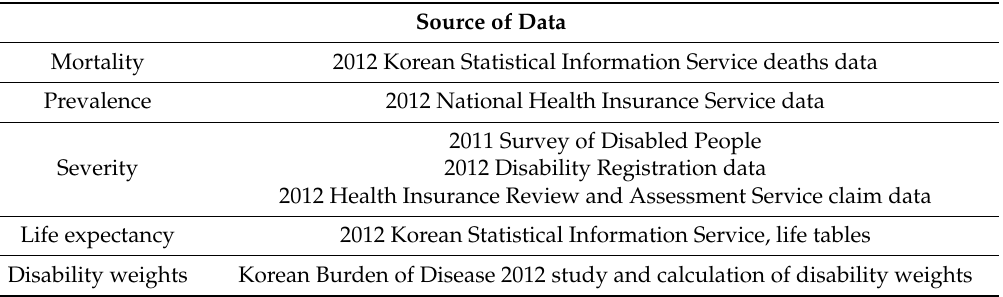
Table 2. Source of